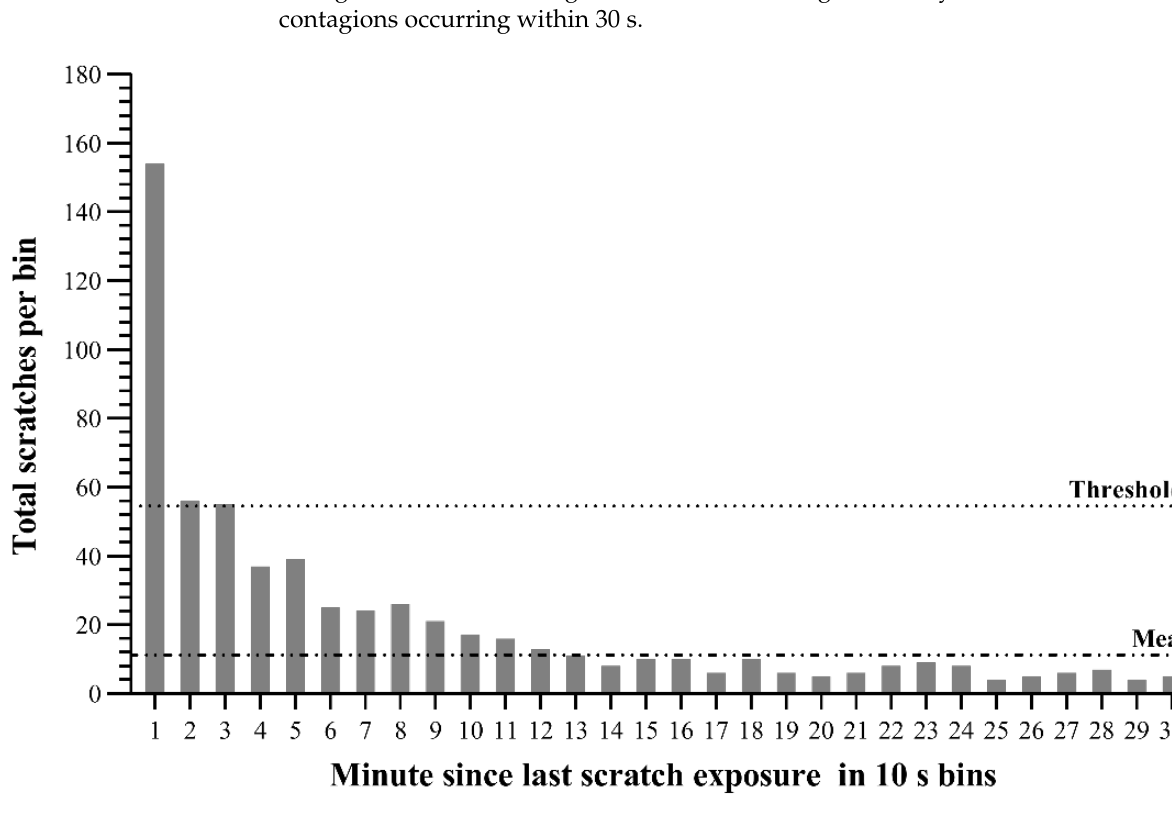
Figure 1. A graph of the number of scratches per 10 s bin. The mean and standard deviation were calculated from all bins (up to minute 10), only showing the first 5 min for clarity. Before 300 s passed, the strength of scratch contagion decreased significantly with time delay, and this decline continued after that. Contagion occurs quickly after seeing the triggered scratch and lasts until 30 s after the triggered scratch.